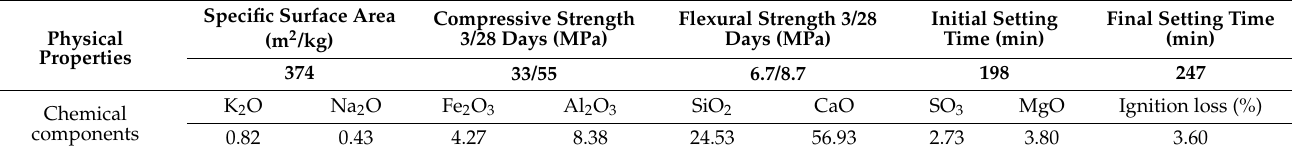
Table 1. The physical properties and chemical components of cement.